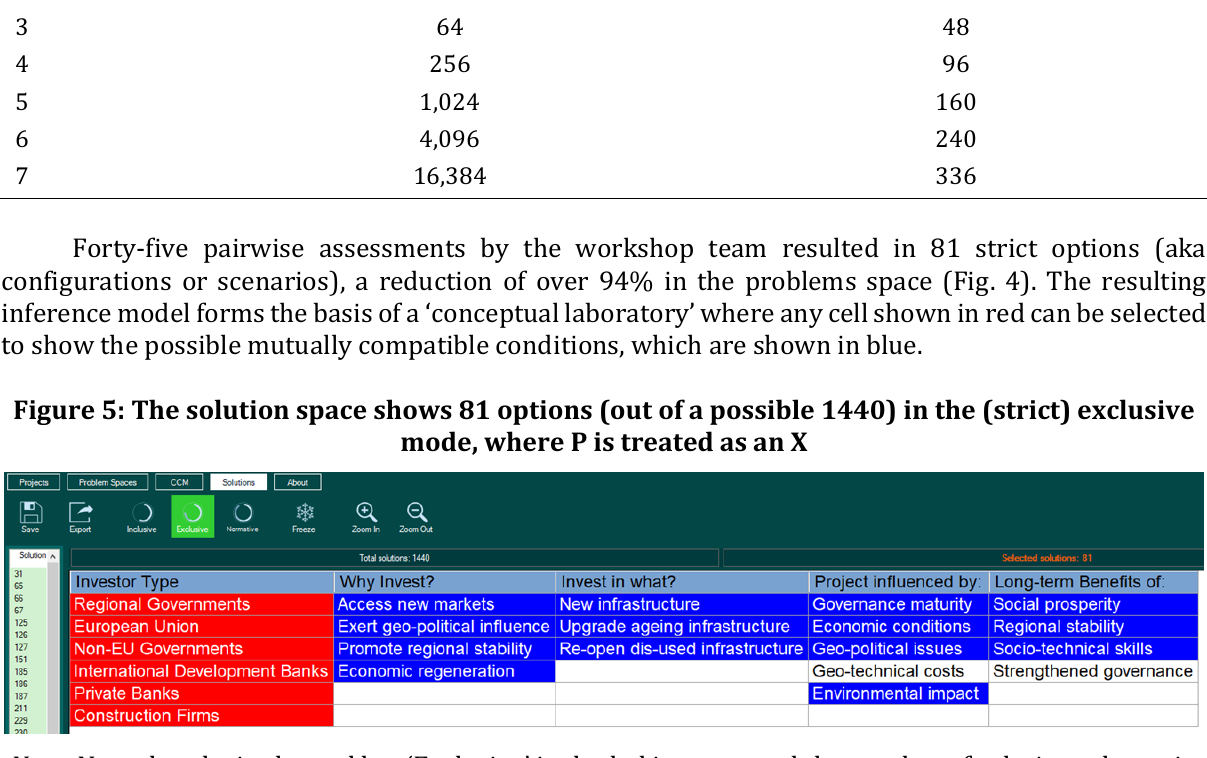
Note: Note that the in the tool bar ‘Exclusive’ is shaded in green and the number of solutions shown in red text in top right-hand side